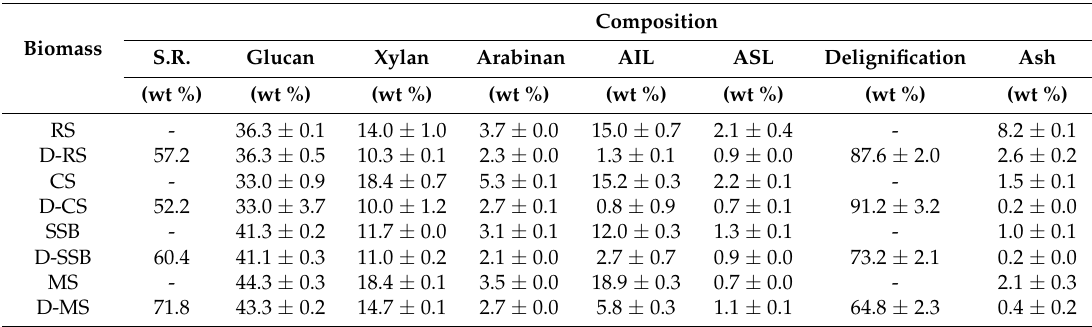
Table 1. Chemical composition of untreated and delignified